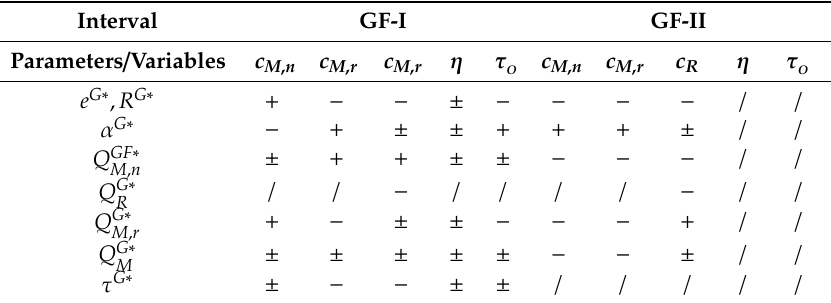
Table 8. Relationships between variables and parameters in the GF model. Interval GF-I GF-II Parameters /